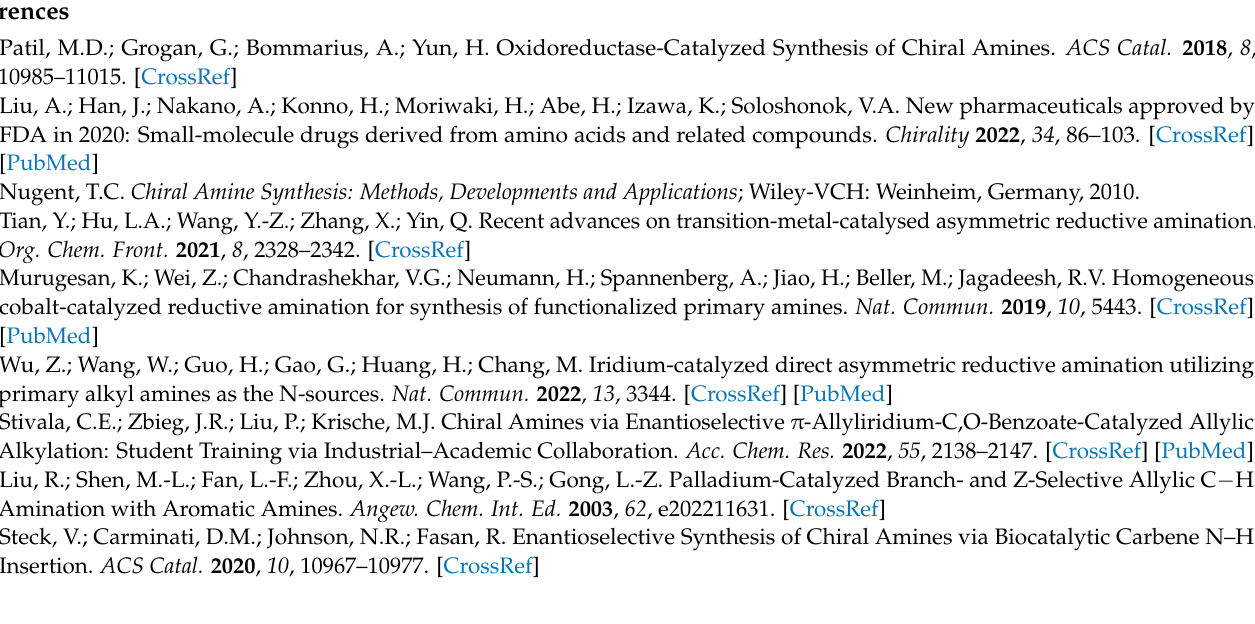
Figure S1: Spectra of substrate I with C3 (69 % ee ) and C4 (60 % ee ) respectively; Figure S2: Spectra of substrate II with C3 (53 % ee ) and C4 (52 % ee ) respectively; Figure S3: Spectra of substrate III with C3 (54 % ee ) and C4 (52 % ee ) respectively; Figure S4: Spectra of substrate IV with C3 (54 % ee ) and C4 (42 % ee ) respectively; Figure S5: Spectra of substrate V with C3 (55 % ee ) and C4 (54 % ee ) respectively; Figure S6: Spectra of substrate VII with C3 (56 % ee ) and C4 (75 % ee ) respectively; Figure S7.:Spectra of substrate IX with C3 (47 % ee ) and C4 (48 % ee ) respectively; Figure S8: Spectra of substrate X with C3 (55 % ee ) and C4 (51 % ee ) respectively; Figure S9: Spectra of substrate I with C8